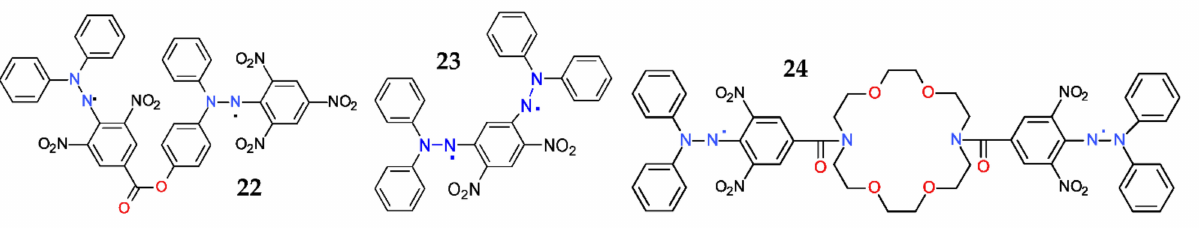
Figure 14. Structure of some dihydrazyls (homo-diradicals).